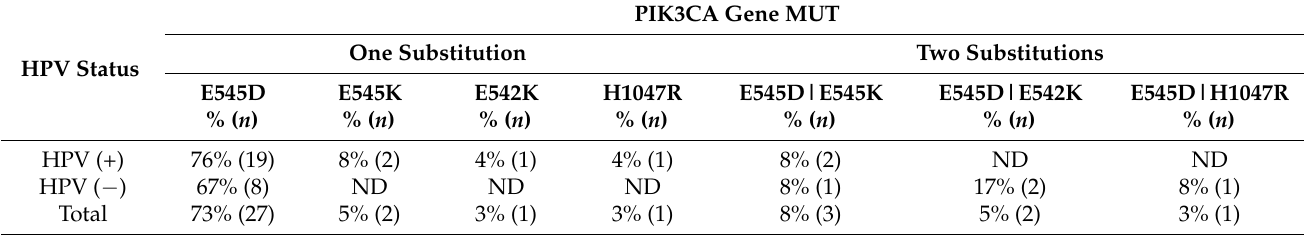
Table 3. Classification of PIK3CA gene mutations (substitutions H1047L and E542K, E545K, and